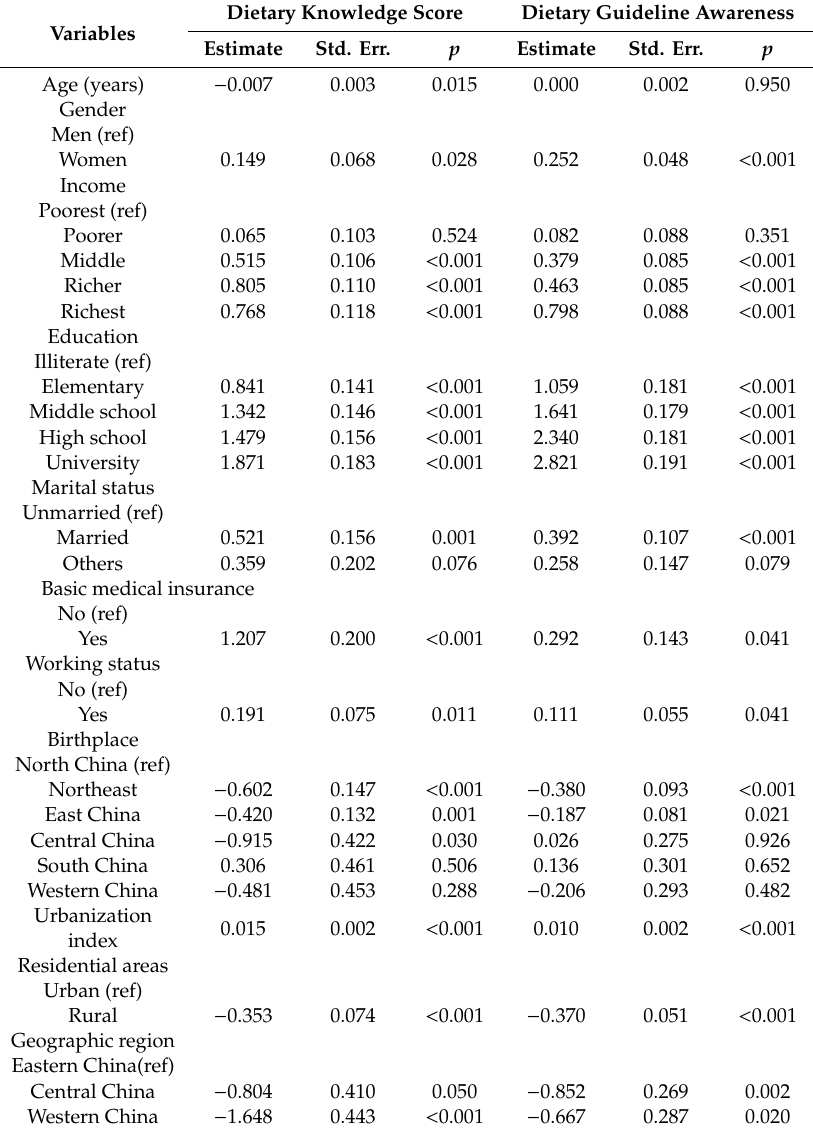
Table 4. Adjusted association between the dietary knowledge score and dietary guideline awareness. Dietary Knowledge Score Dietary Guideline Variables